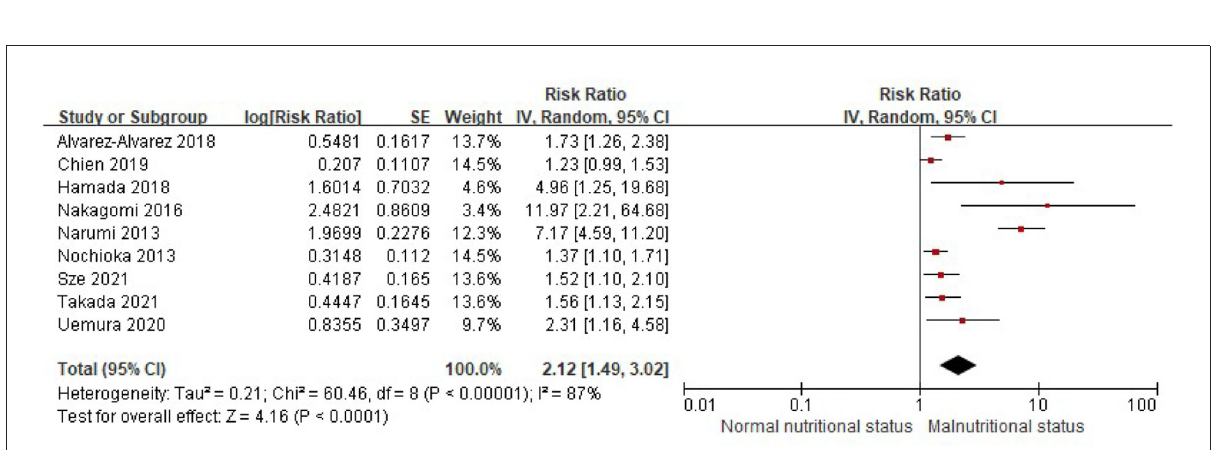
FIGURE6 A forest plot of comparison: The risk of MACEs in patients with HF associated with malnutrition status defined by the CONUT score. CONUT, controlling nutritional status; HF, heart failure; MACEs, major adverse cardiac